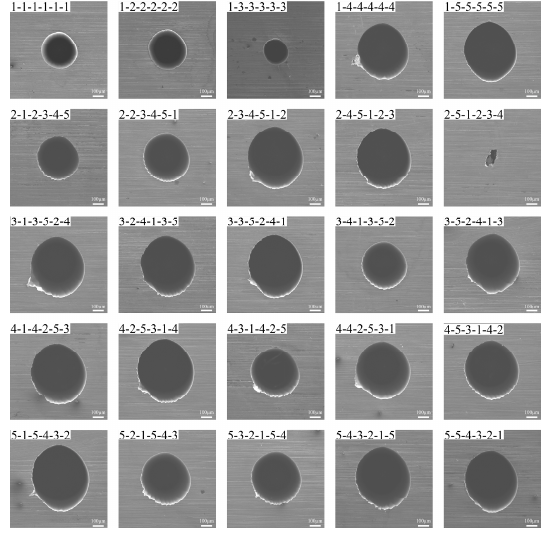
Figure 9. Morphology of femtosecond laser exit hole.